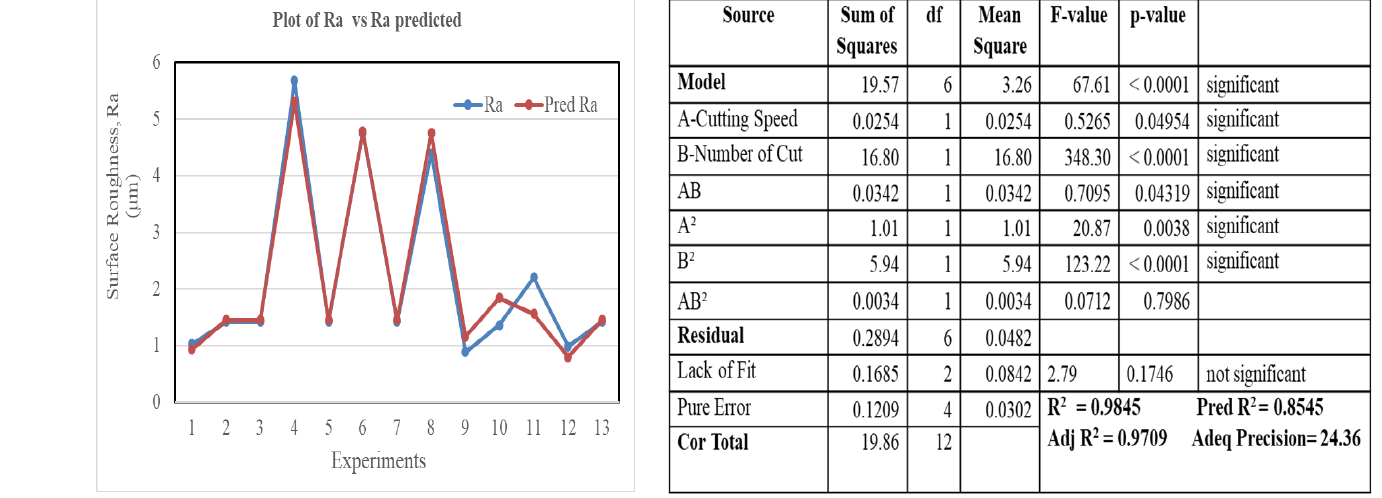
Figure 15. Plot of Ra vs predicted Ra, ANOVA model for Ti-6Al-4V.